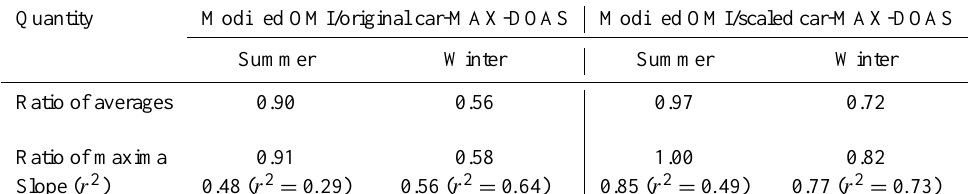
Table 4. Ratios of daily average and maximum values (modified OMI/car-MAX-DOAS) as well as slopes and correlation coefficients of the regression analyses for measurements at large circles and OMI effective CF below 0.3. For the correction of the car-MAX-DOAS observations see text.